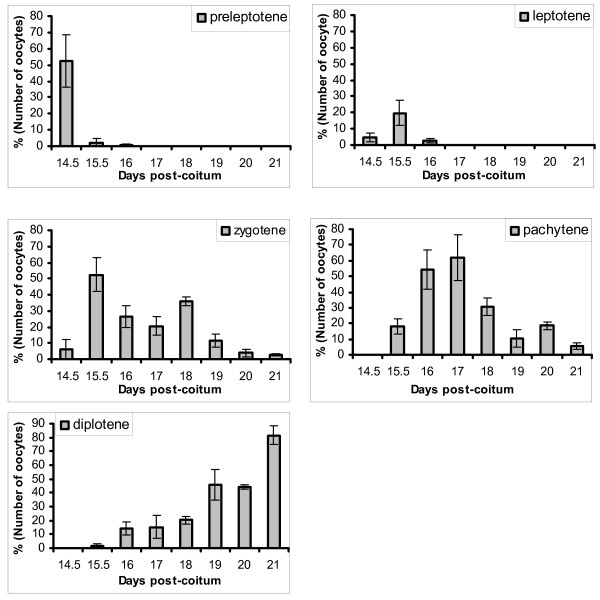
The proportions of fetal mouse oocytes in different stages of meiotic prophase I between 14.5 and 21 days post coitum. Note, two waves of zygotene peaking on 15.5 and 18 dpc, followed by two waves of pachytene on 17 and 20 dpc. Note also the persistence of some pre-diplotene stages of oocytes until day 21, two days after birth.